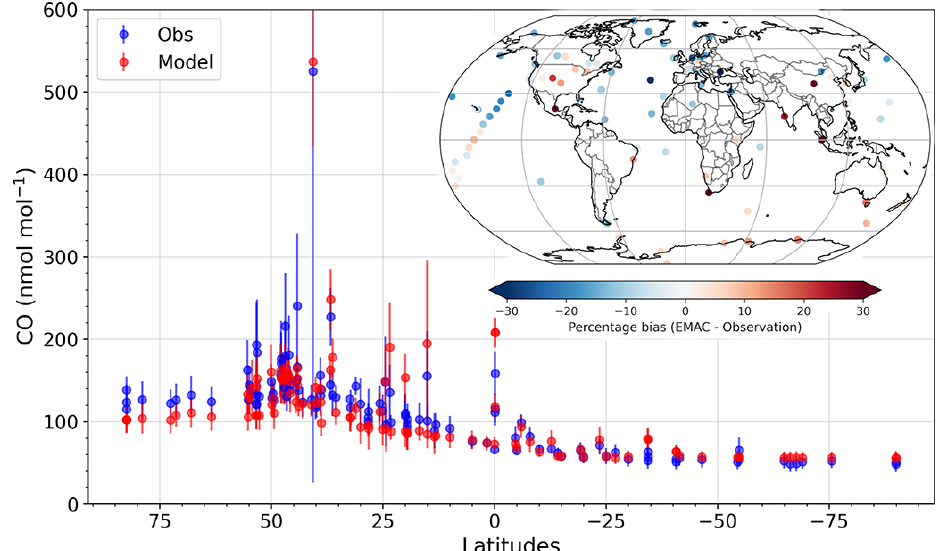
Figure 5. Latitudinal gradient of the annual mean (2010) of the measured and simulated surface CO mixing ratio at the WDCGG measure- ment stations. The error bars show the 1 σ standard deviation of the annual mean (based on daily mean output). The map in the inset shows the annual bias between the simulation and measurements at the locations of the WDCGG stations.